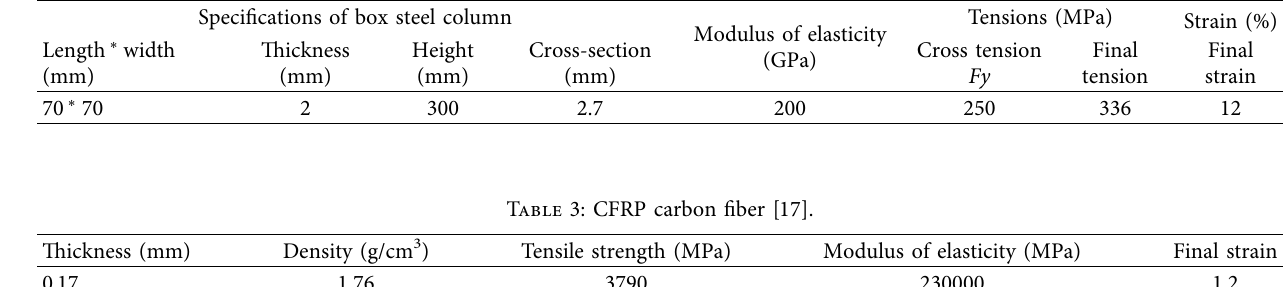
Table 2: Dimensions and characteristics of box steel column [17].